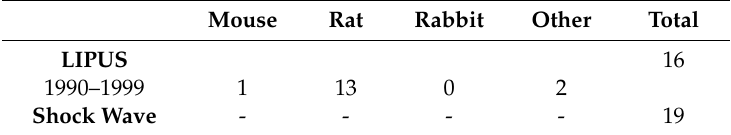
Table4. Preclinicalstudiescarriedoutindi ff erentanimalmodelsforothertissuehealing(LIPUSorshock wave treatment alone or combined with other therapies, e.g., MSC, grafts, or chemical compounds). Mouse